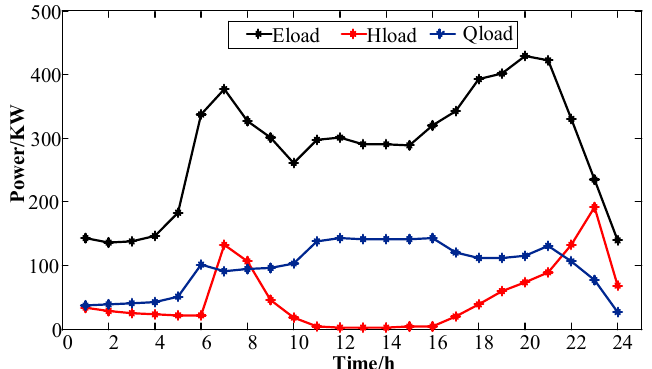
Figure 5. Cold, hot and electrical load curves.